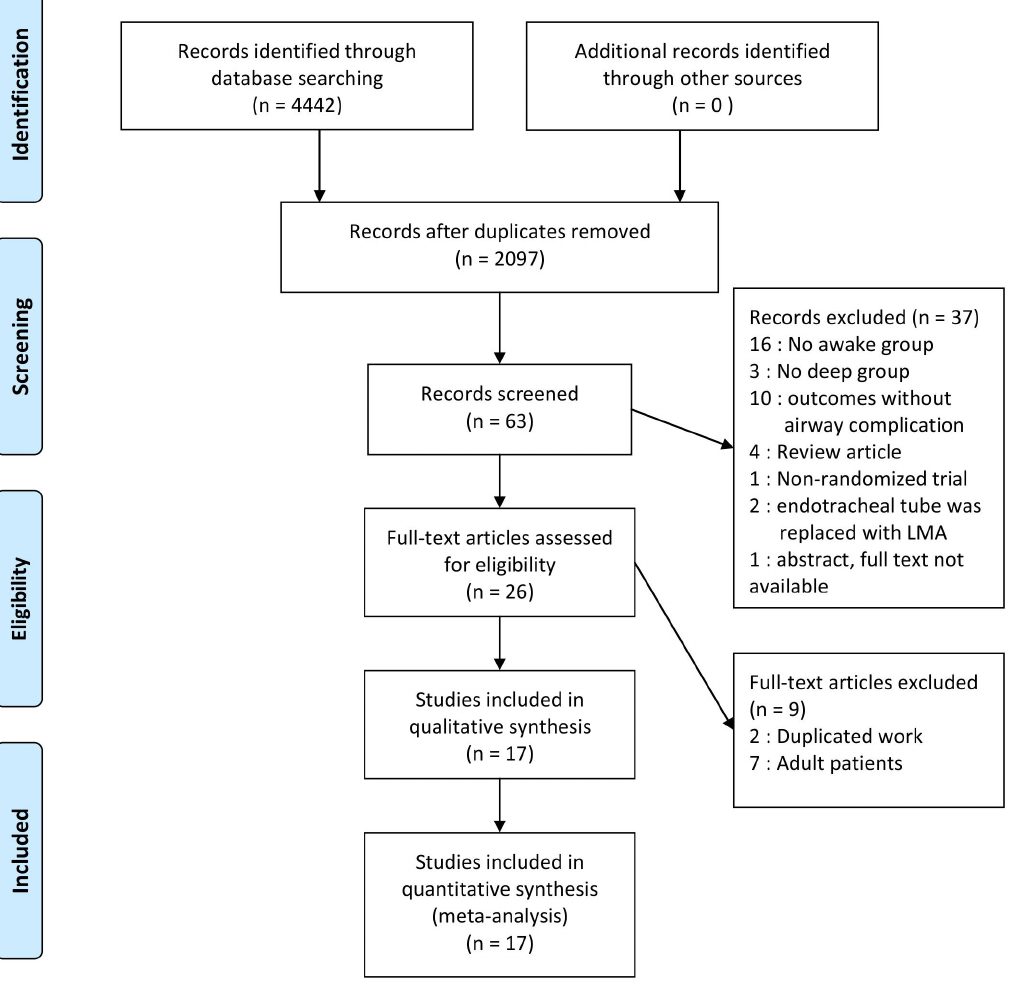
Figure 1. Flow diagram of the included and excluded